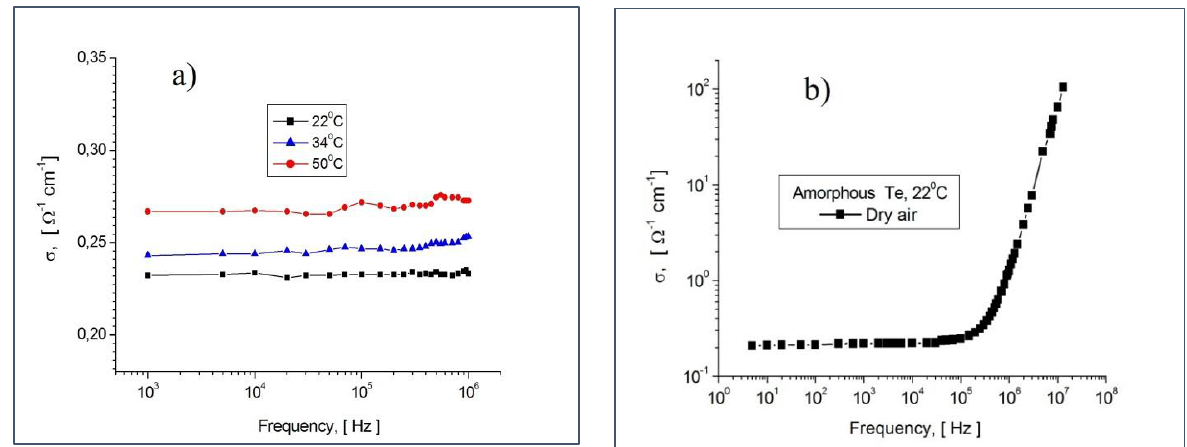
Figure 4. The spectra of AC conductivity of nanocrystalline (a) and amorphous (b) tellurium